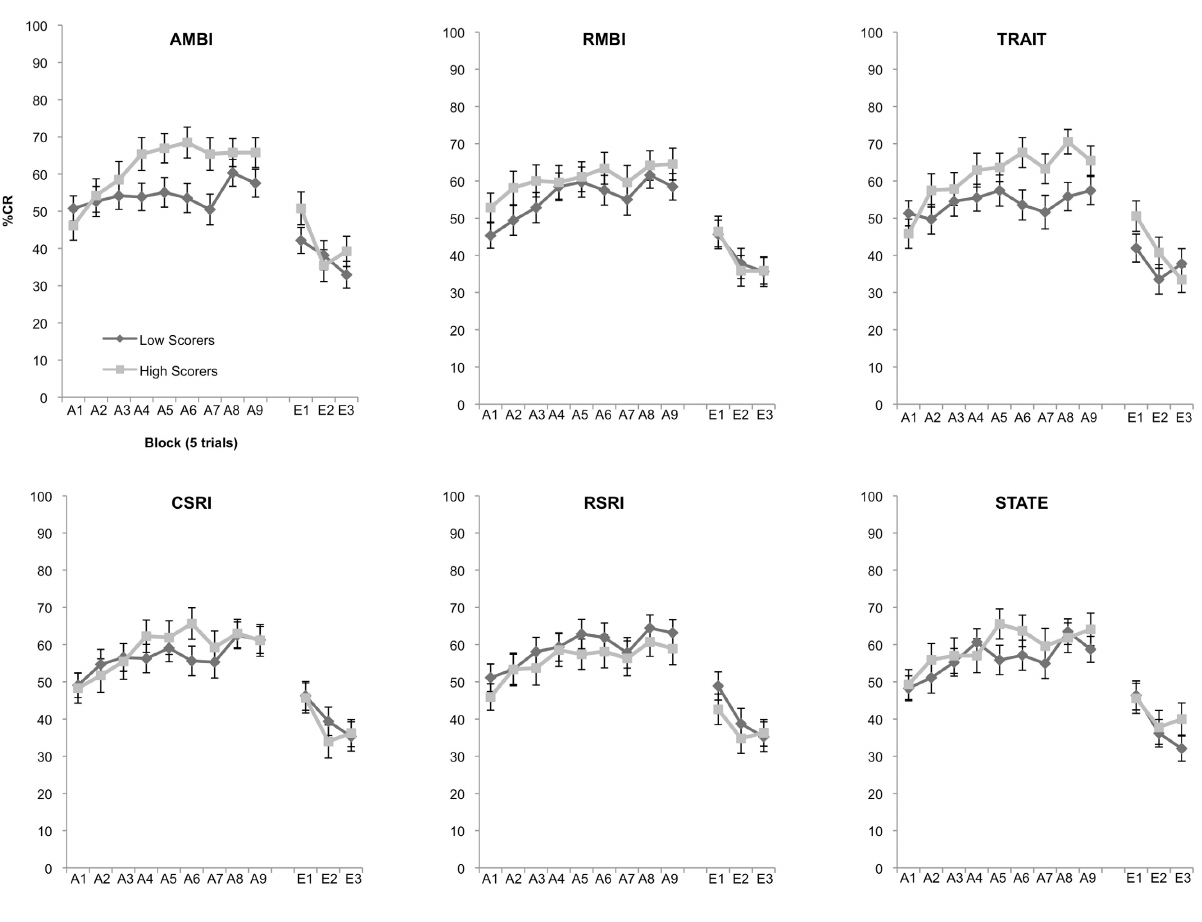
AMBI, F ( 8 , 912 ) = 2 . 401, p = 0 . 014, and STAI-Trait, F ( 8 , 912 ) = 3 . 137, p = 0 . 002. No other measures were able to significantly differentiate